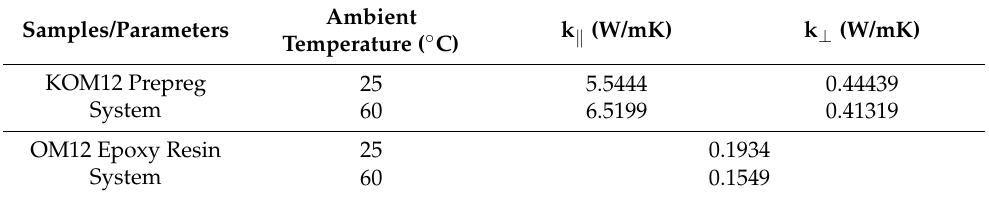
Table 7. Anisotropic/isotropic thermal conductivity results of the experiments.